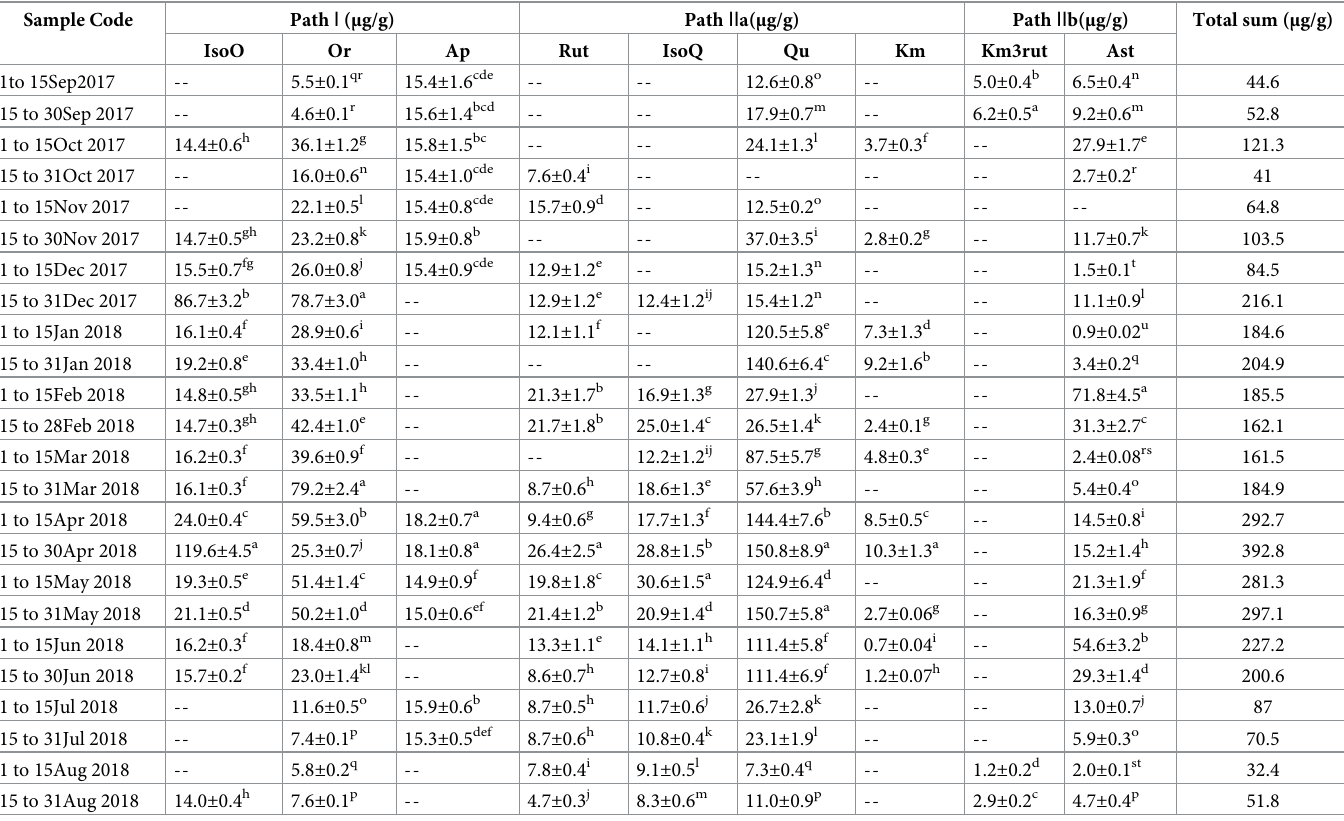
Table 1. Total content and individual content of nine flavonoids identified in T . hemsleyanum from 1 September 2017 to 31 August 2018. Sample